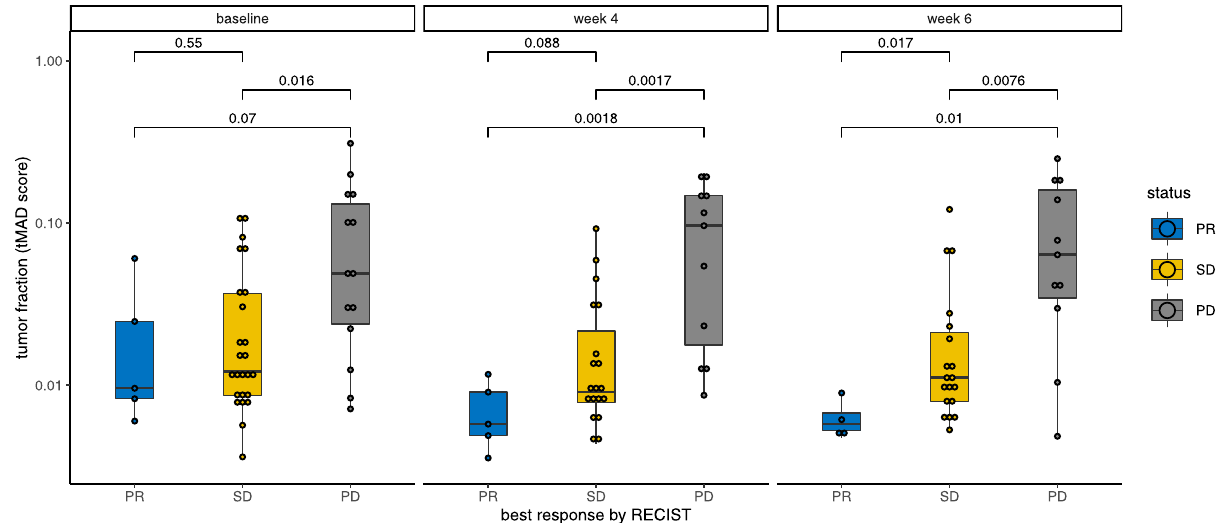
Fig. 3 Modi fi cations in the ctDNA tumour fraction measured with the t-MAD score from the baseline and early post-treatment samples (~week 4 and week 6). p values for the Wilcoxon tests are indicated above the boxplots. Samples are separated based on the best overall response on RECIST (blue = PR, yellow = SD, grey = PD). There were n = 44 biologically different samples at baseline, 35 at week 4 and 34 at week 6. All samples are indicated by dots. Boxplot centre is the median, bounds of box represent 25 and 75 percentile, lines are 10 and 90 percentile. Source data are provided as a Source Data fi